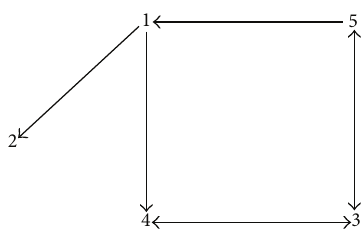
Figure 1: Directed communication graph of five